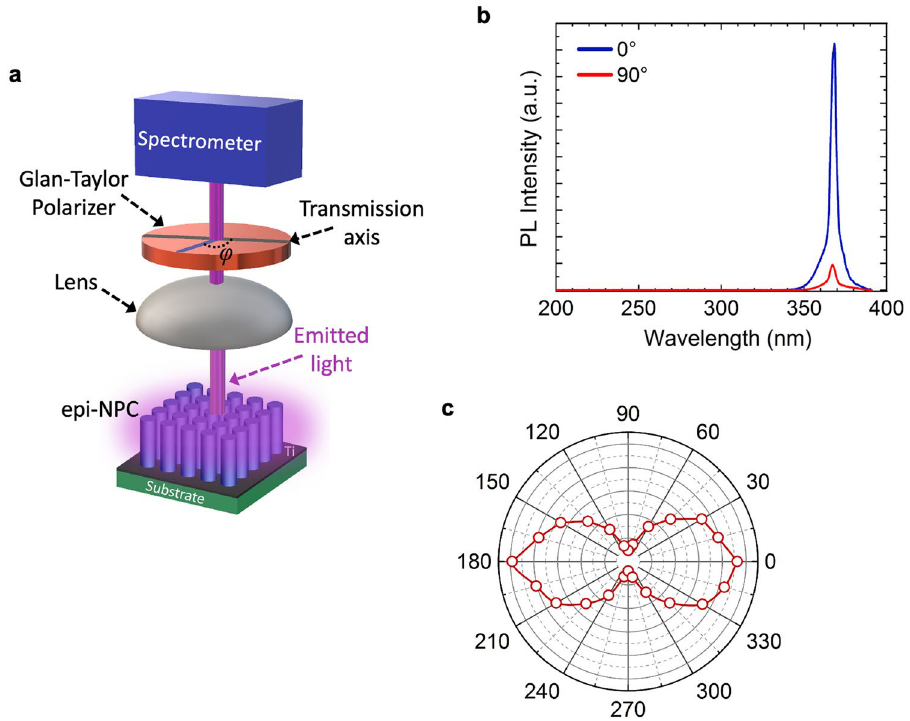
Figure 4. ( a ) The schematic of the in-plane polarization measurement at Γ point. ( b ) Polarized light emission from the NPC at φ = 0° and φ = 90°. ( c ) Plot of the light intensity measured from the NPC at different in-plane angle φ . The excitation density was 63.5 kW/cm 2 .